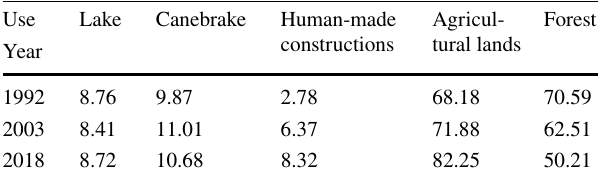
Table 6 The change in land-use area over the three time periods (Hectare) Use